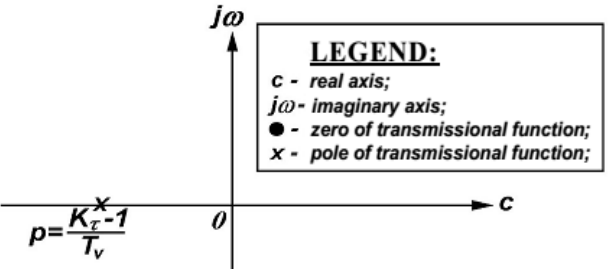
Figure 7. PN-diagram of oscillatory transporting platform during the sieving of wet earth